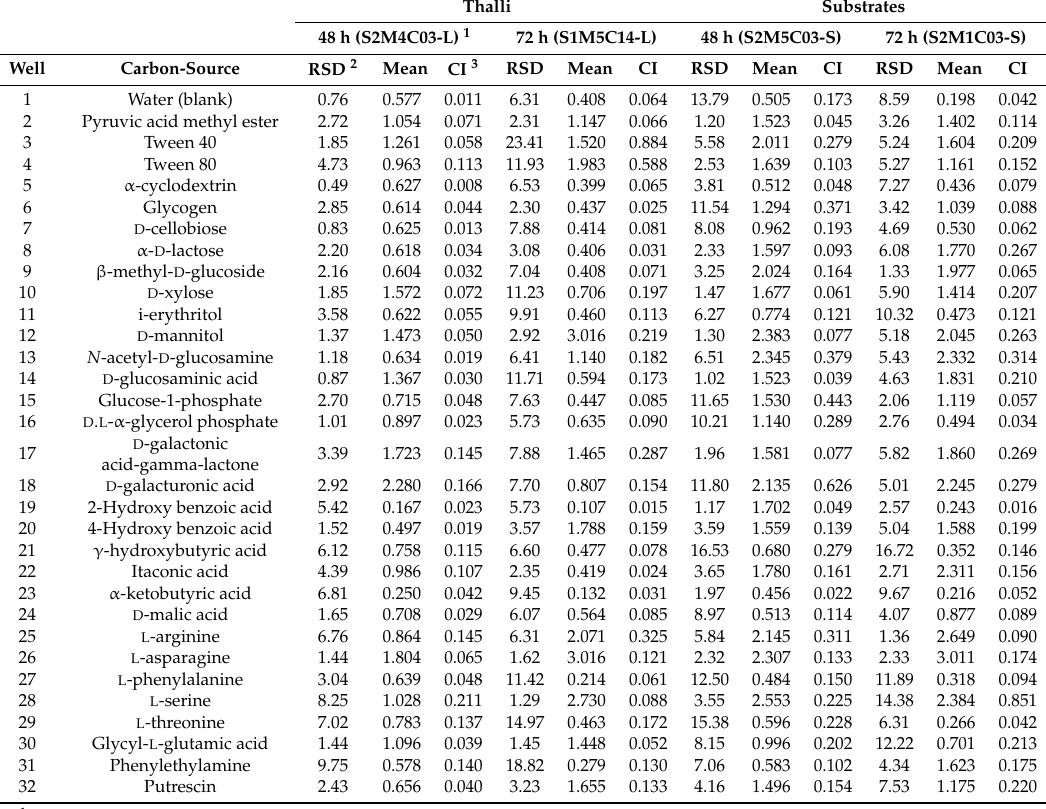
Table A1. Experimental uncertainty and precision of the measurements of absorbance used for analyzing the carbon-source utilization patterns of the microbial communities associated with lichen thalli and substrates. Test samples were randomly chosen from each sample batch at each